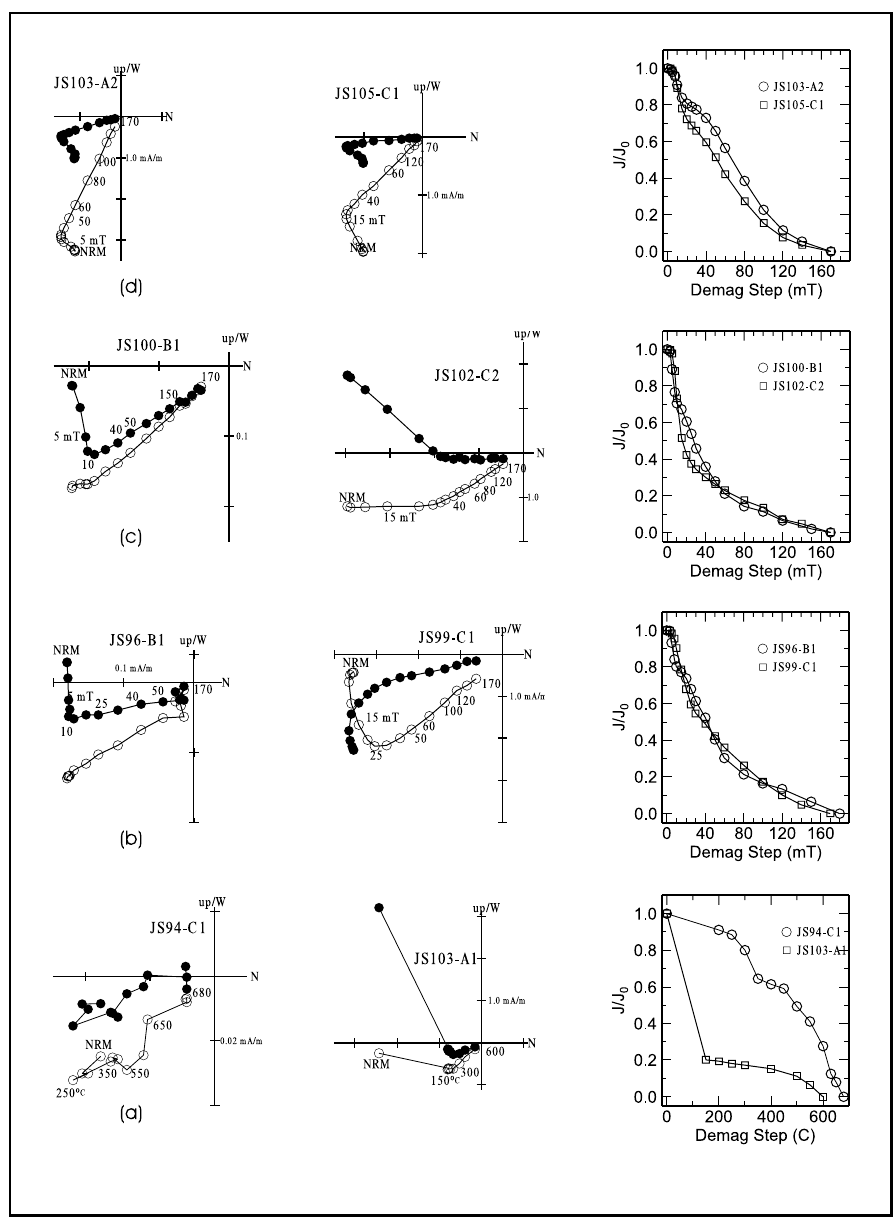
Fig. 3–ExamplesofprogressiveAFandthermaldemagnetizationresultsofsampleswithreversedmagnetic polarity. Right diagrams show the decay of intensity during demagnetizations, and left diagrams show variation of vector end points. For vector diagrams open (solid) circles are vertical (horizontal)